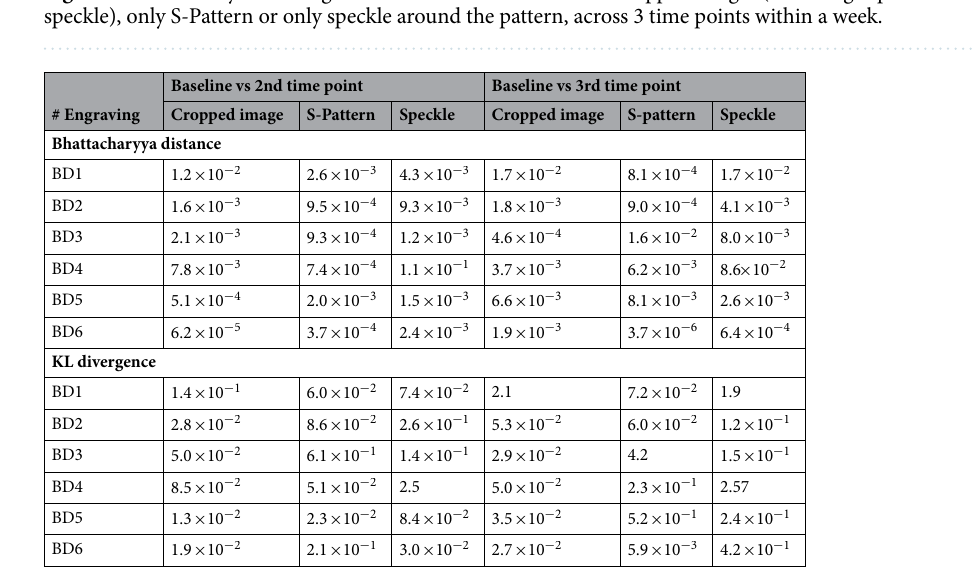
Table 2. Robustness measured by Bhattacharyya distance and Kullback–Leibler (KL)